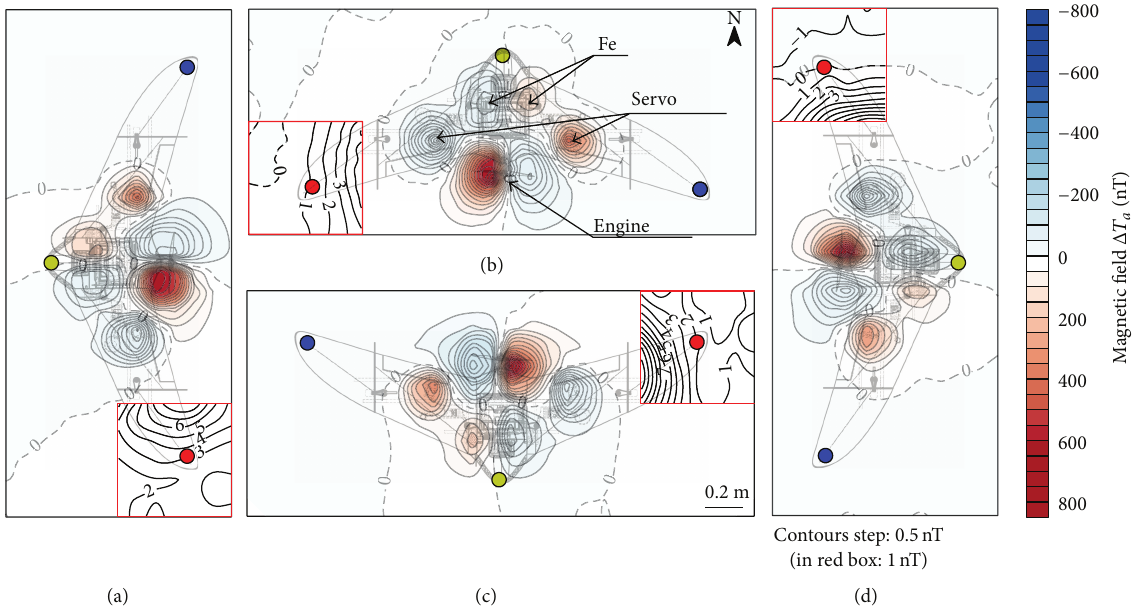
Figure 3: Magnetic field Δ𝑇 𝑎 of UAV for its different orientation at the Earth’s magnetic field: (a) west; (b) north; (c) south; (d) east.